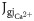
Schematic of the biophysical model.A model for a ChR2-expressing astrocyte is presented, accounting for: 1) Ca2+ release from the endoplasmic reticulum (ER) into the cytosol via the IP3R clusters, 2) Phospholipase-C δ1 (PLCδ1) mediated production of IP3, 3) capacitive calcium entry (CCE) via the store operated calcium channel (SOC), 4) passive leak from the ER to the cytosol (Jleak), 5) replenishment of ER stores via sarco(endo)plasmic reticulum Ca2+-ATPase (SERCA) pump, 6) extrusion of Ca2+ by plasma membrane Ca2+ ATPase (PMCA) pump into the extracellular (EC) space, 7) passive leak (Jin) into the cytosol from the EC space, and 8) Ca2+ buffering by endogenous buffer proteins. In astrocytic network simulations (bottom panel), each cell is connected to its neighboring cells though Ca2+ and IP3 permeable gap junctions, indicated as JgjCa2+ and JgjIP3, respectively, and a central region (blue shaded box) is stimulated with light. A 4-state model [closed states (c1 and c2) in red and open states (o1 and o2) in blue] is used to represent ChR2 gating dynamics. The blue light (λ = 470 nm) stimulation paradigm used to open ChR2, leading to a Ca2+ influx (JChR2), is characterized by pulse period (T) and pulse width (δ).